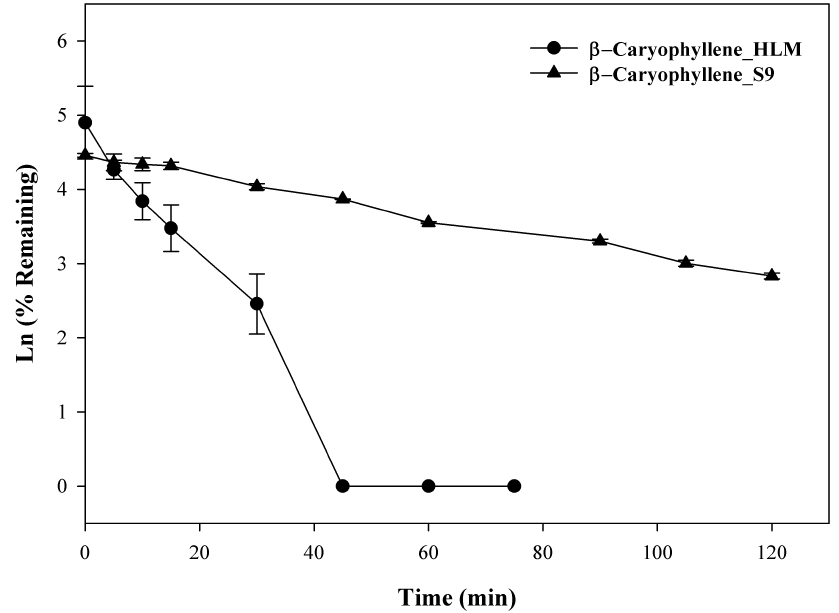
Figure 3. Time-dependent metabolic depletion of β -caryophyllene in pooled human liver microsome and human S9 fractions. Human liver microsomes and human S9 fractions were incubated with β -caryophyllene (10 µM) for 0 – 75 min and 0 – 120 min in presence of cofactors, respectively. The data are expressed as mean ± SEM ( n = 3).